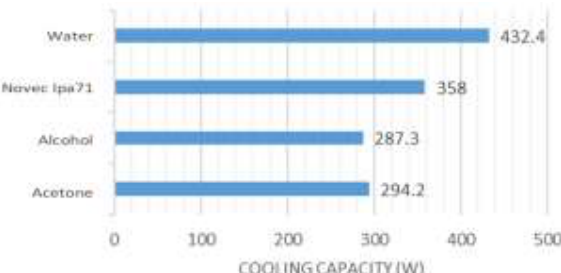
Fig. 12. Comparison of cooling capacity, load 1 000 W, volume 100 %.